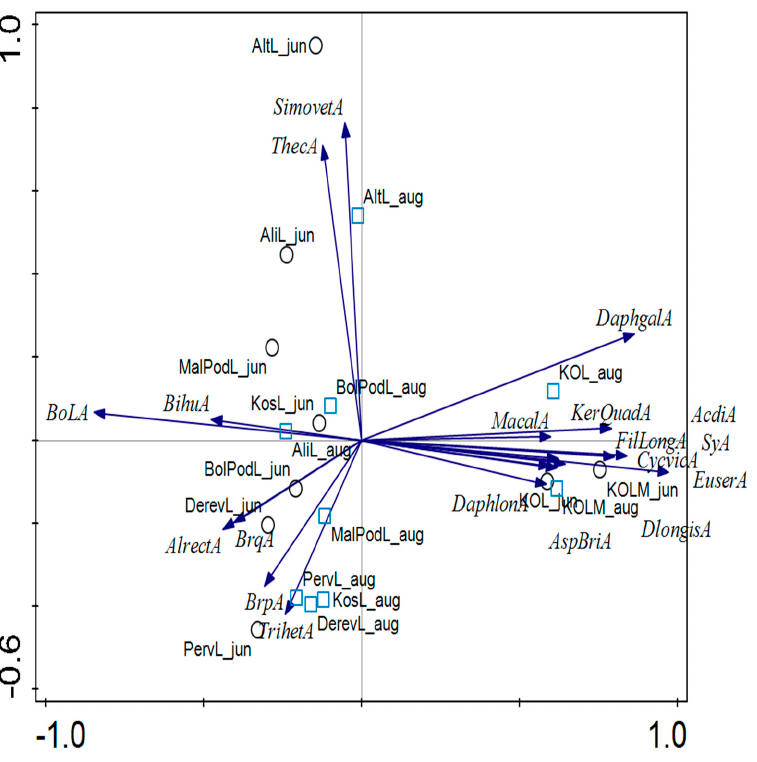
Figure 6. RDA correlation biplot of zooplankton and environmental variables. Circles—June, quadrangles—August, blue arrows − biological variables. Abbreviations used in the fi gure: